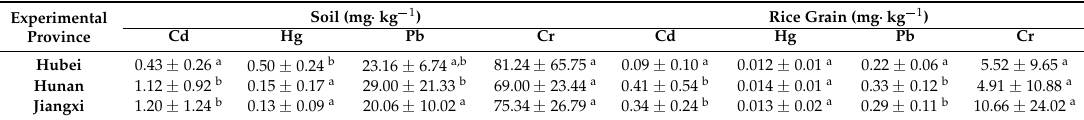
Table 3. The average concentrations of heavy metals in soil and rice. Experimental